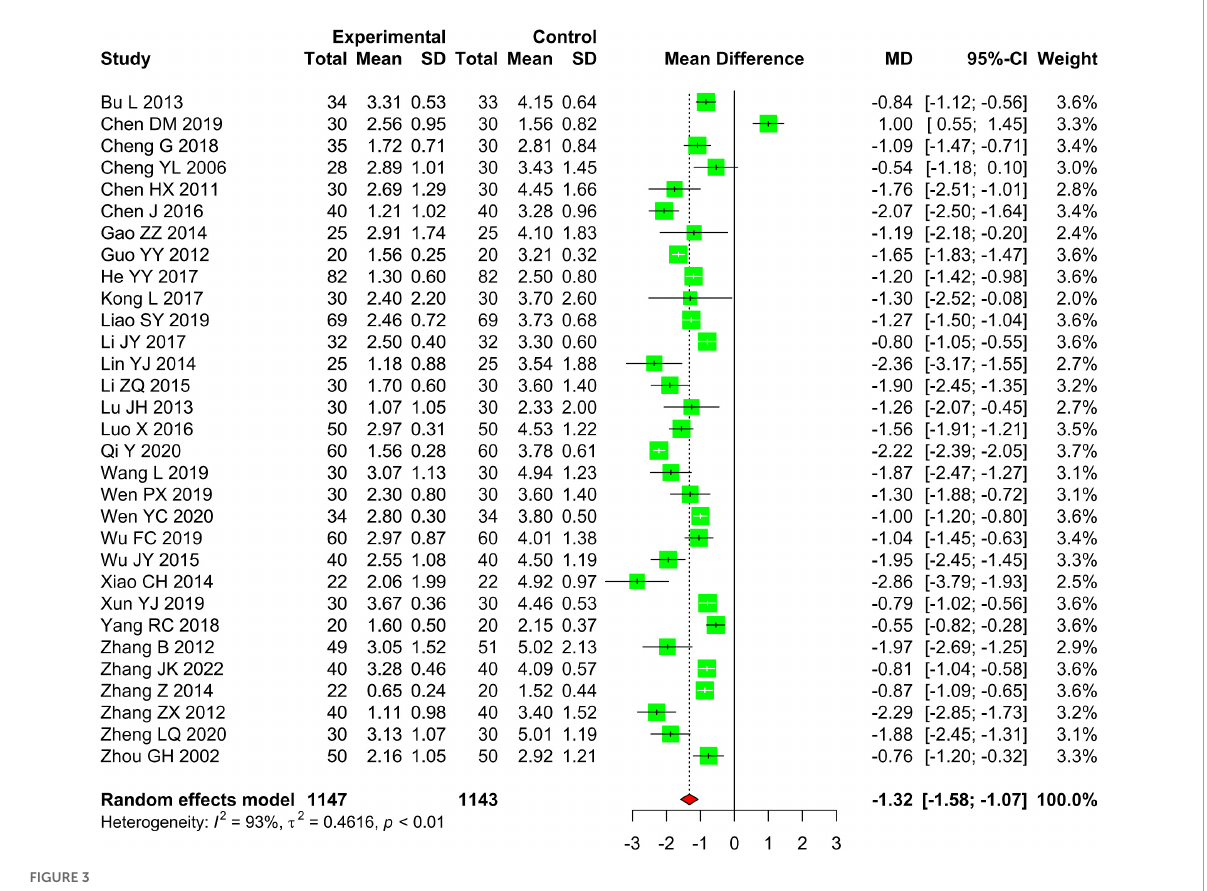
FIGURE3 Forest plot and meta-analysis of